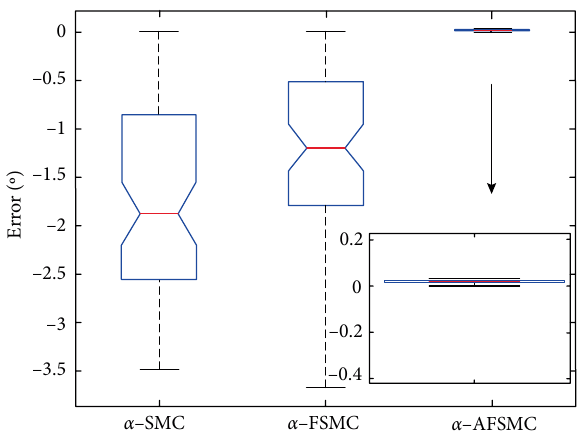
Figure 24: The tracking response of the second driving force